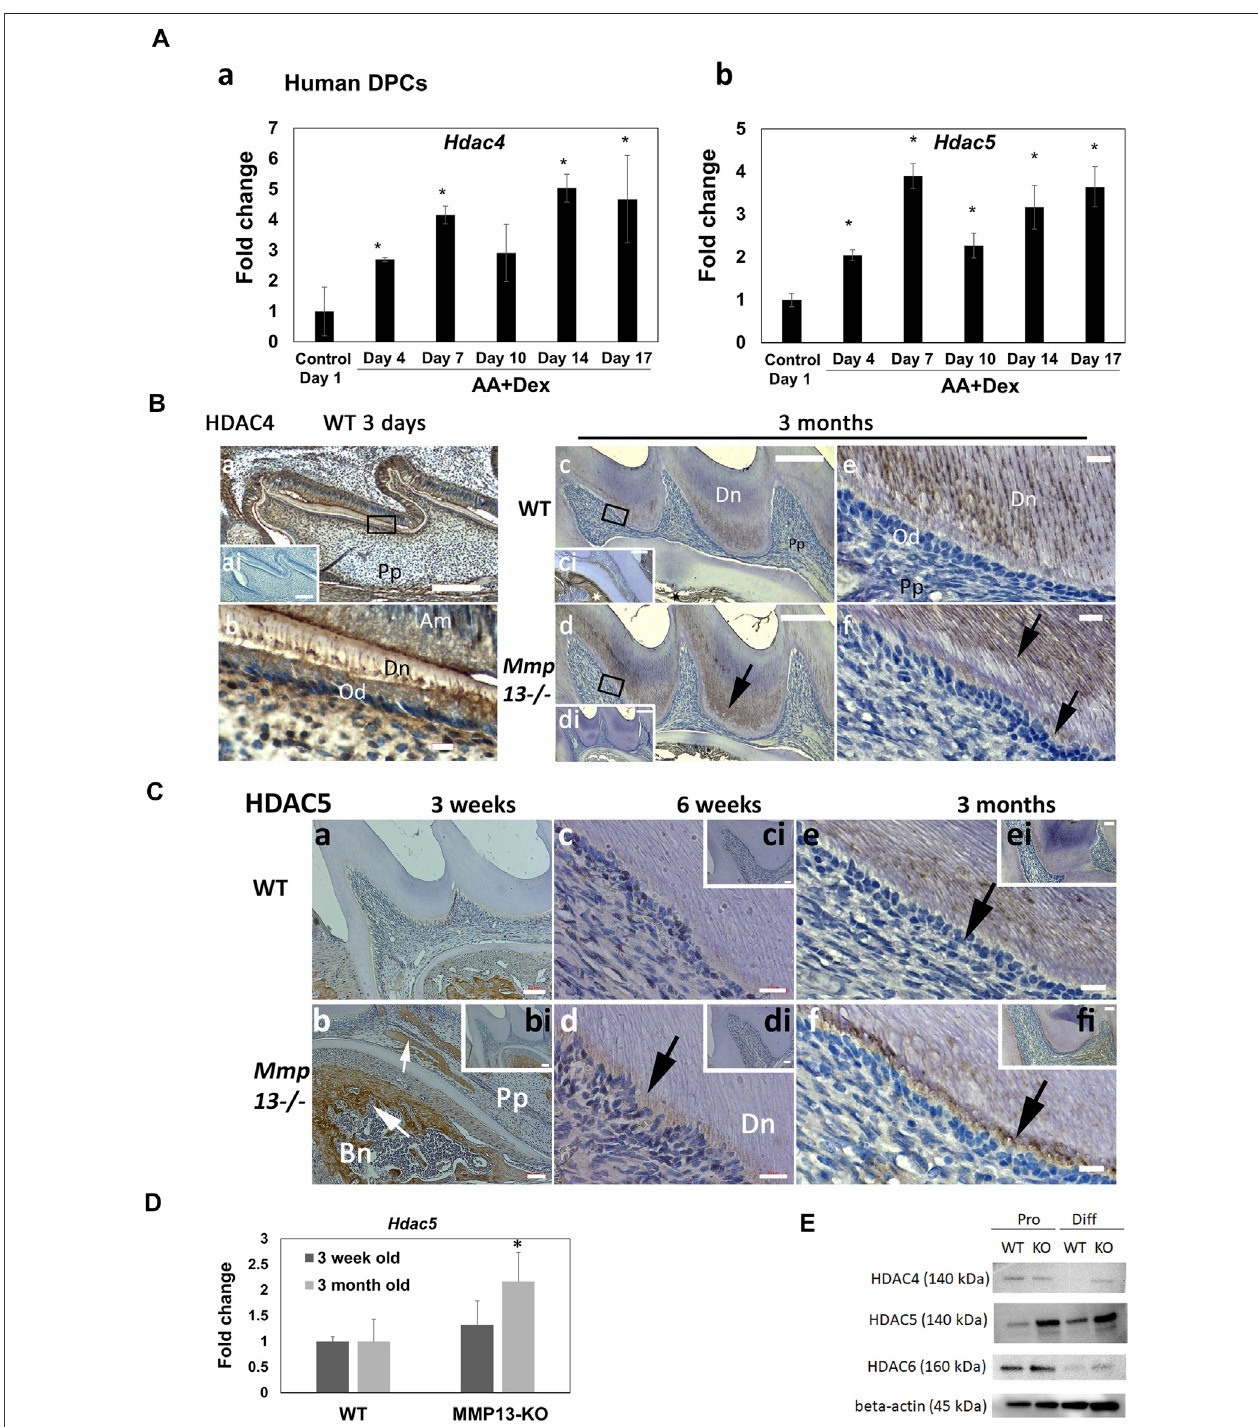
FIGURE 6 | Expression of mineralization-associated HDAC, HDAC4 and HDAC5, in the dentin – pulp complex increased during human-DPC mineralization and after MMP13-loss. (A) Time-course human-DPC-culture indicates a progressive signi fi cant increase in both Hdac4 and 5 expressions during mineralization. (B) IHC- HDAC4 expression decreases in adults compared with developing teeth (a – f) . HDAC4 demonstrated high expression at post-natal 3-day WT samples in the odontoblastlayer (a,b) comparedwithunstainedcontrol( ai — inset).Inadultsamples,reducedexpressionofHDAC4 (c – f) wasdemonstratedinpulp,odontoblast (e, f), and predentin, with increased expression in mineralized dentin. Higher expression in dentin ( d, f — black arrows) and odontoblast (f) was evident in Mmp13 − / − samples(blackarrows).HighHDAC4expressioninadultalveolarbone( c -blackstar; ci inset — whitestar)wasevident. ai anddirepresentunstainedcontrolsofaandd,